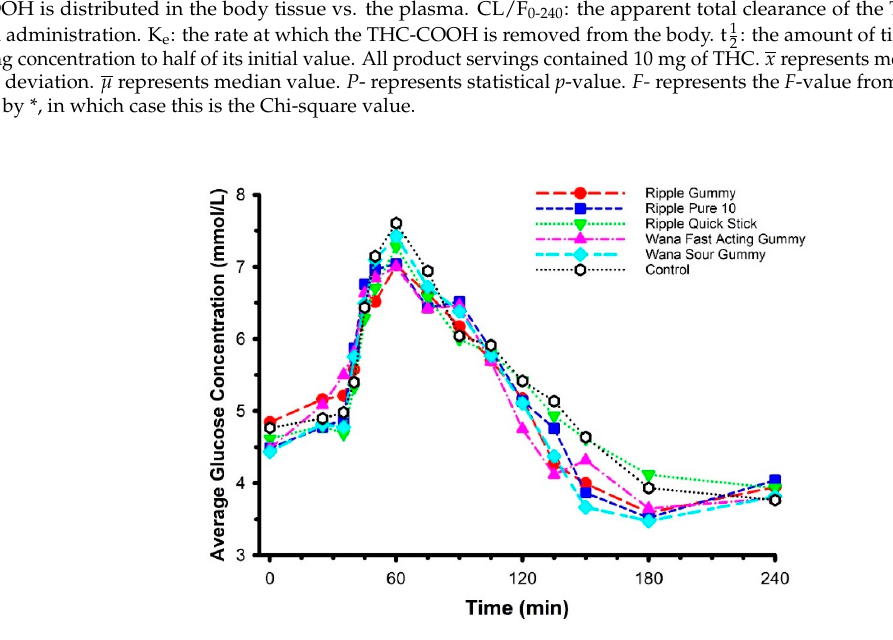
Figure 6. Mean circulating insulin concentrations following ingestion of two commercially available edible marijuana (10 mg of THC) and one marijuana-free control product. Seventy-five grams of glucose was ingested at 30-min. There were no differences in circulating insulin between products (product × time interaction p = 0.74). Error bars have been omitted for clarity.